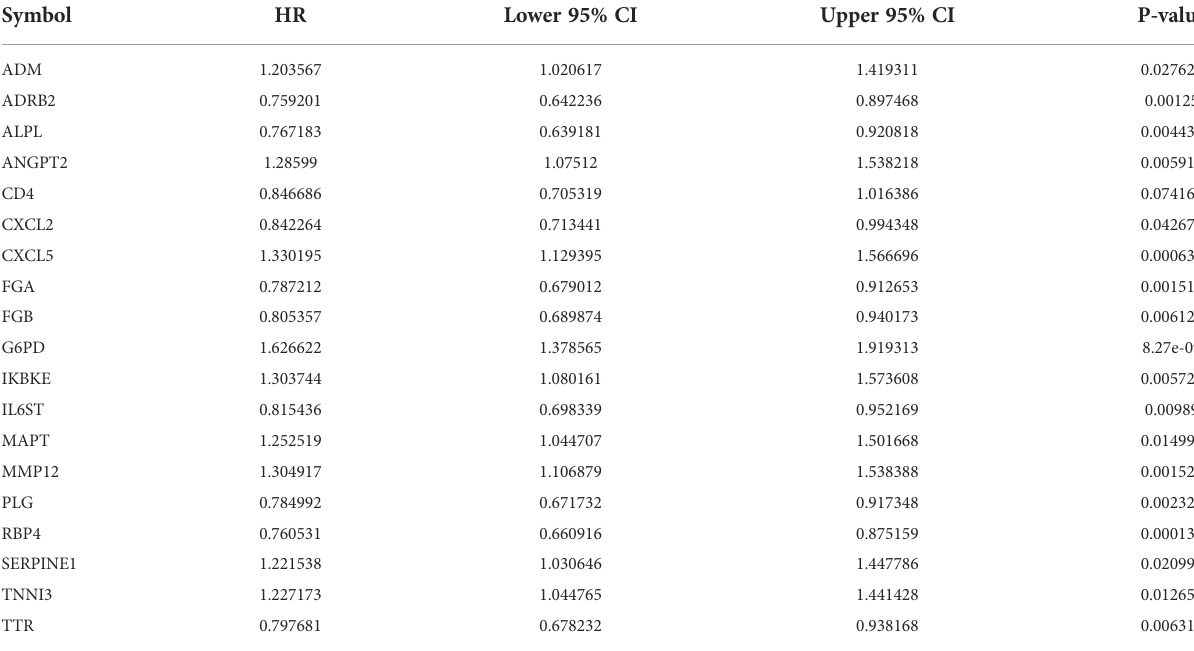
TABLE 1 Univariate Cox regression analysis of COVID-19/HCC related